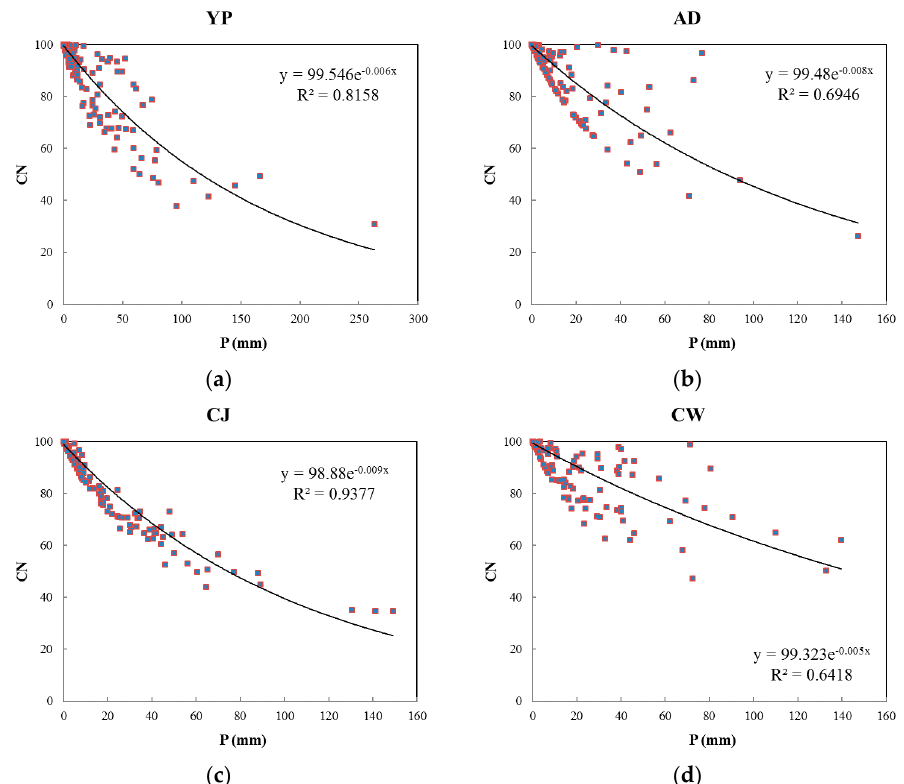
Figure 4. CN–P relationship that describes the curve number estimated with 428 measured rainfall– Figure 4. runoff pairs for two years (2011, 2012) from 1 March to 30 September at four sites: ( a ) YP; ( b ) AD; ( c ) CJ; and ( d ) CW. ( b ) AD; ( c ) CJ; and ( d )